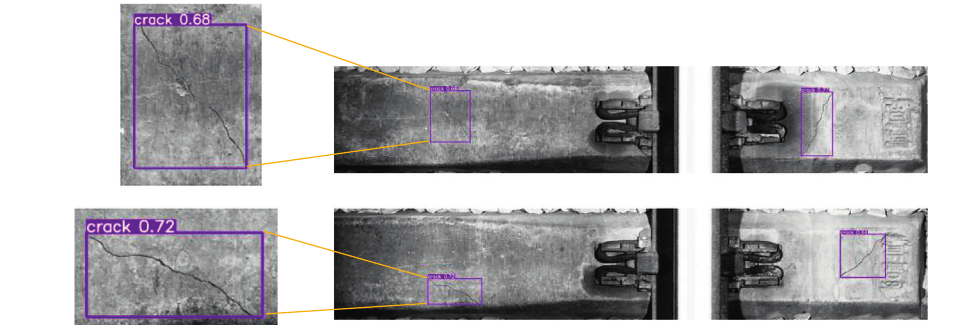
Figure 11: Sleeper crack location. Table 7: Comparison of crack detection results.